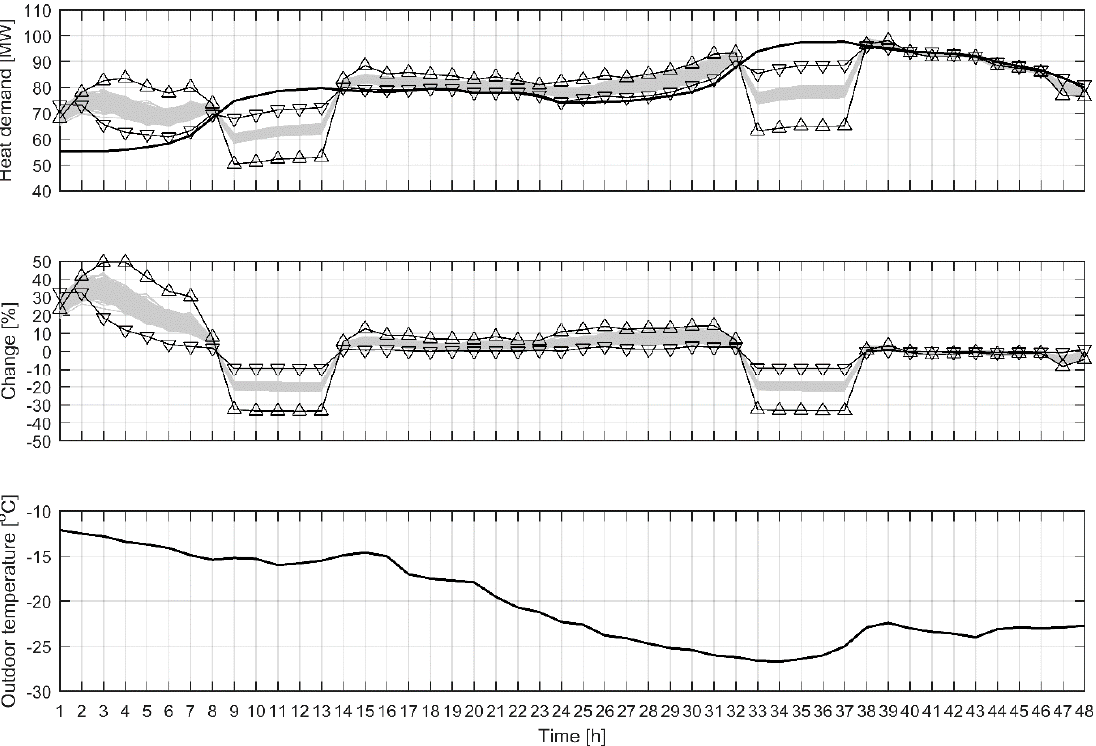
Figure 6. Peak load cutting in 201 buildings during the morning hours from 8–12 a.m. Upper figure: Black line is the predicted total heat demand in 201 buildings, the grey lines are the 1000 different optimized heat demands when peak load cutting is performed and the black lines with upward and downward triangles are the optimized heat demands with maximum and minimum peak loads, respectively. Middle figure: Grey lines are the load cuts in percentages with 1000 different optimized heat demands and the black lines with upward and downward triangles are the maximum and minimum load cuts in percentages respectively. A negative number corresponds to the reduction in heat demand and a positive number to the increase in heat demand.